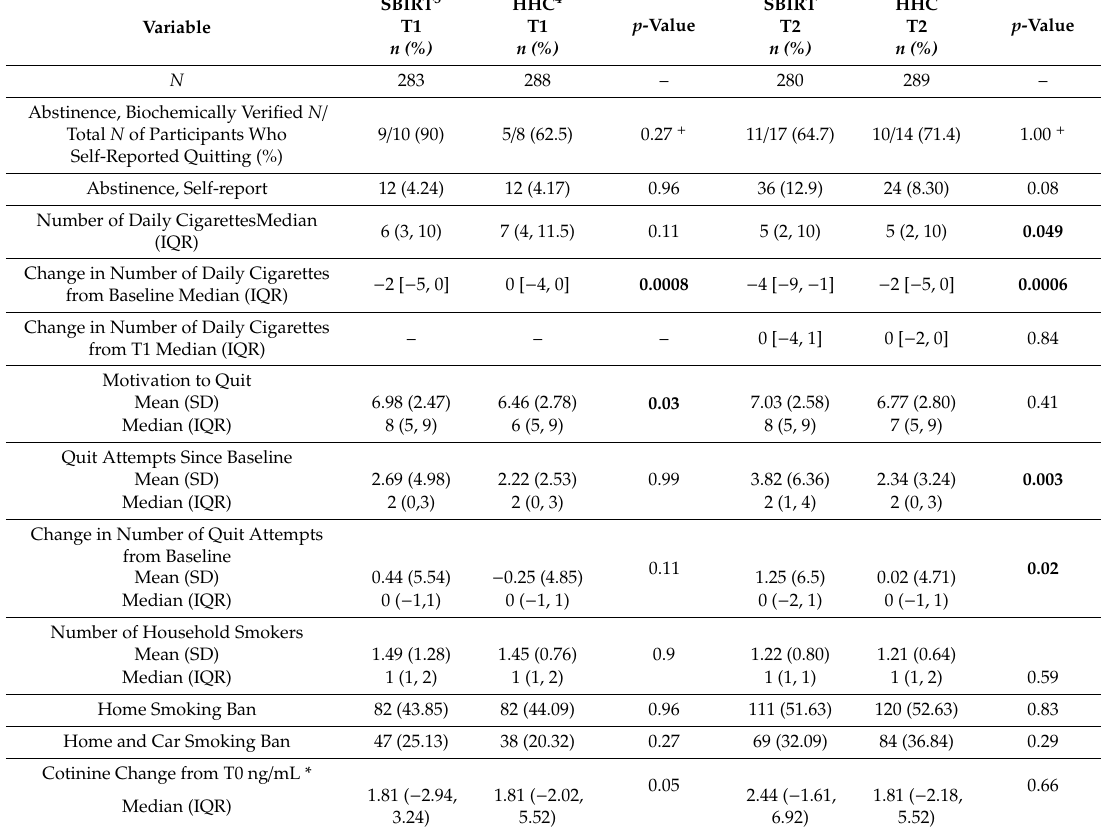
Table 2. Primary and secondary outcomes at T1 1 and T2 2